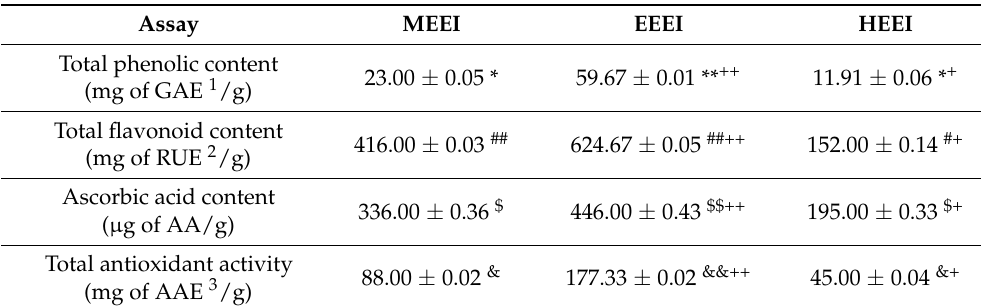
Table 3. Total phenolic, flavonoid, and ascorbic acid content, and total antioxidant capacity in Enteromorpha intestinalis extracts.